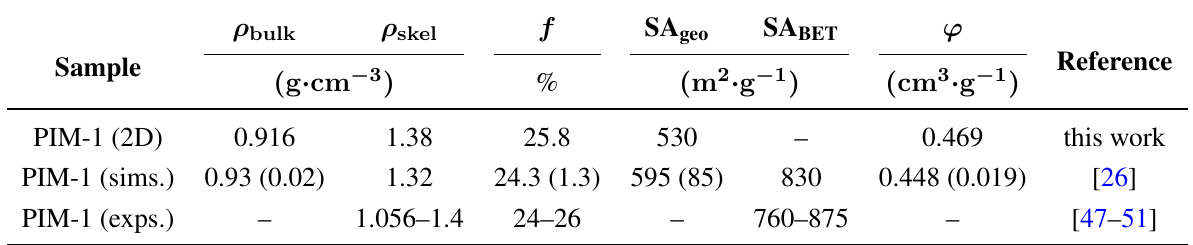
Table 1. Porosity characteristics of PIM-1 simulated (sims.) and experimental (exps.) samples.